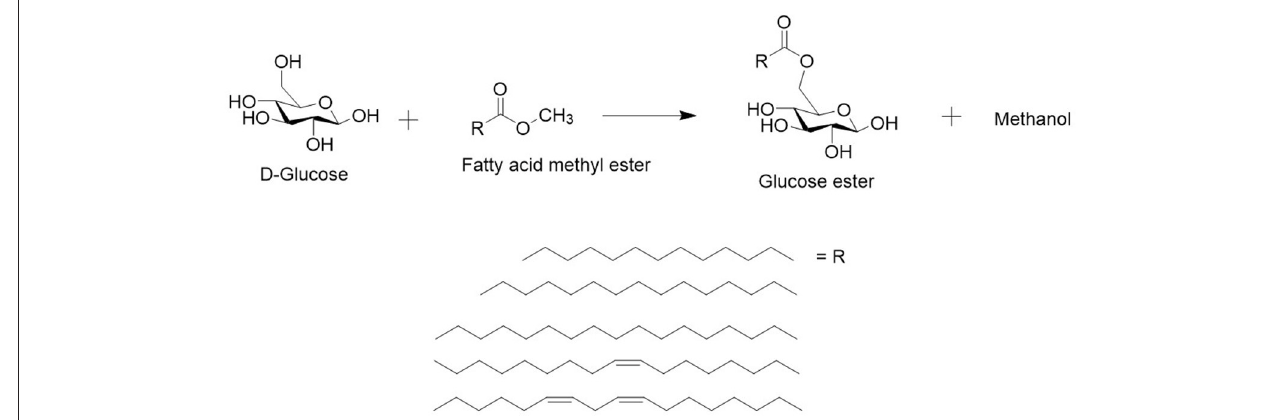
FIGURE 3 | Lipase catalyzed transesterification reaction in the DES with sugar (e.g., glucose) and a methylated fatty acid ester produced from SCO (methyl myristate, methyl palmitate, methyl stearate, methyl oleate and methyl linoleate). The reaction leads to a sugar ester and methanol as side product. Methanol can enter the gas phase and push the reaction forwards or inhibit the enzyme.